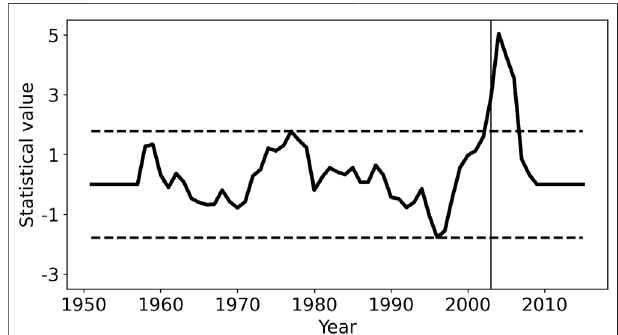
FIGURE 3 | Decadal shift in the total number of days of extreme precipitation according to a running t -test and Lepage test, respectively. The dashed lines represent thecriticalvaluesatthe95%signi fi cancelevel,and the thin vertical line denotes the change year of 2003.